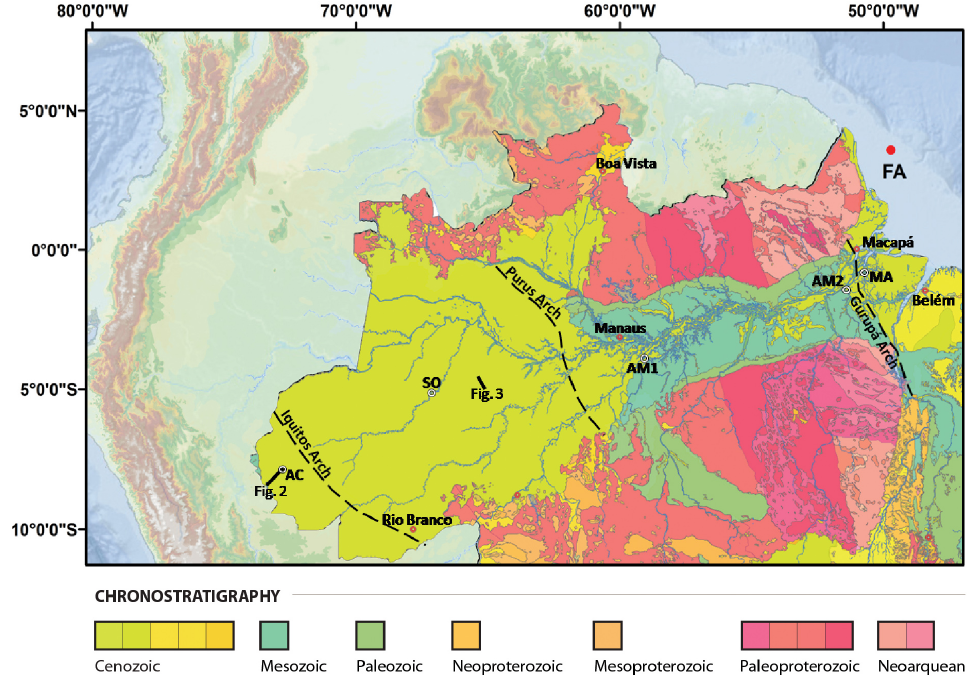
Figure 1. Geologic map of the Amazon region. Note that the newly revised geologic map of Brazil shows that the sedimentary cover of the Amazon basin is Cenozoic (not Cretaceous as shown here; see Caputo, 2011). Also shown are the locations of seismic lines in Figs. 2 and 3 and proposed drill sites. Drill site locations are shown for the Acre (AC), Solimões (SO), Amazon (AM), and Marajó (MA) basins. Each of these basins is separated from the adjoining basin by structural arches, as shown on the